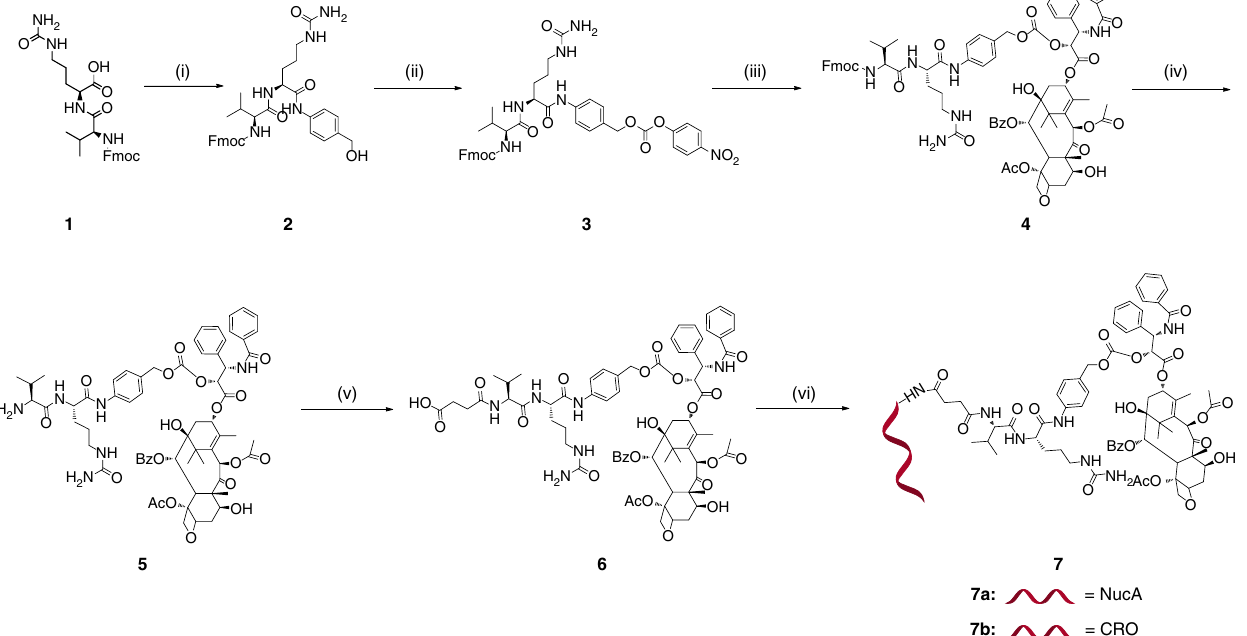
Fig. 1 Synthesis of aptamer-paclitaxel conjugates. Note for reagents and conditions: (i) PABOH, EEDQ, CH 2 Cl 2 /CH 3 OH; (ii) PNP chloroformate, pyridine, THF; (iii) PTX, DMAP, CH 2 Cl 2 ; (iv) piperidine, DMF; (v) succinic anhydride, DIPEA, THF; (vi) Sulfo-NHS, EDCI, aptamer, dd-H 2 O, DMF, 0.5 M Na 2 CO 3 / NaHCO 3 . Fmoc = 9-Fluorenylmethoxycarbonyl, PABOH = 4-Aminophenylmethanol, EEDQ = N -ethoxycarbonyl-2-ethoxy-1,2-dihydroquinoline, PNP = p - Nitrophenyl, DMAP = 4-Dimethylaminopyridine, Bz = Benzoyl, Ac = Acetyl, DMF = Dimethylformamide, DIPEA = N , N ′ -Diisopropylethylamine, THF = Tetrahydrofuran, Sulfo-NHS = N -hydroxysulfosuccinimide sodium salt, EDCI = 1-Ethyl-3-(3-dimethyllaminopropyl)carbodiimide hydrochloride, NucA = Nucleolin aptamer, CRO = Cytosine-rich